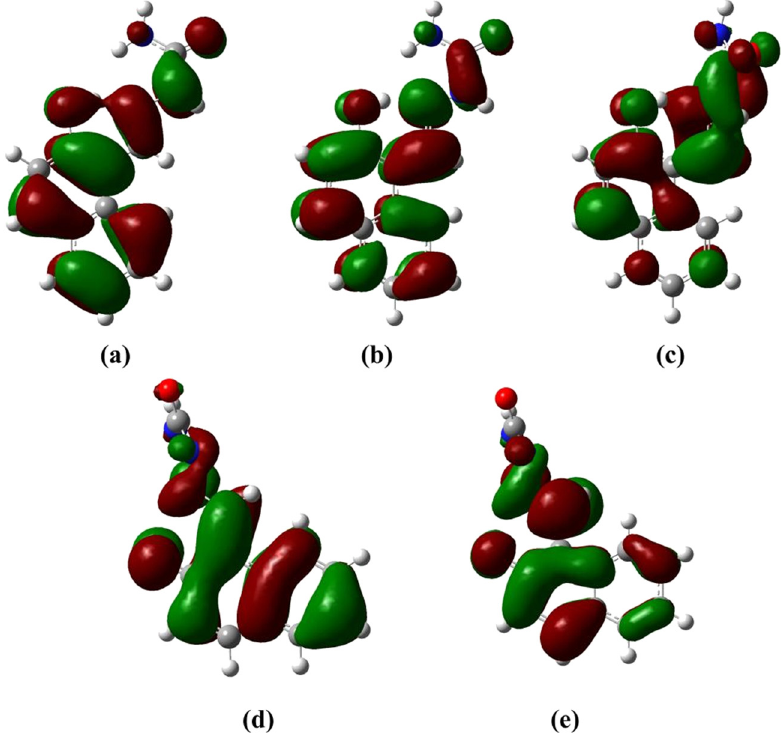
Figure 3: The molecular orbital with the cyclohexane solvation of ( a ) HOMO at the optimized enol S 0 state HOMO [ E 1 ( S 0 )] , ( b ) LUMO at the optimized enol S 0 state LUMO [ E 1 ( S 0 )] , ( c ) LUMO at the optimized enol S 1 state LUMO [ ( ) E S 1⁎ 1 ] , ( d ) HOMO at the optimized keto S 1 state HOMO [ K* ( S )] and ( e ) LUMO at the optimized keto S 1